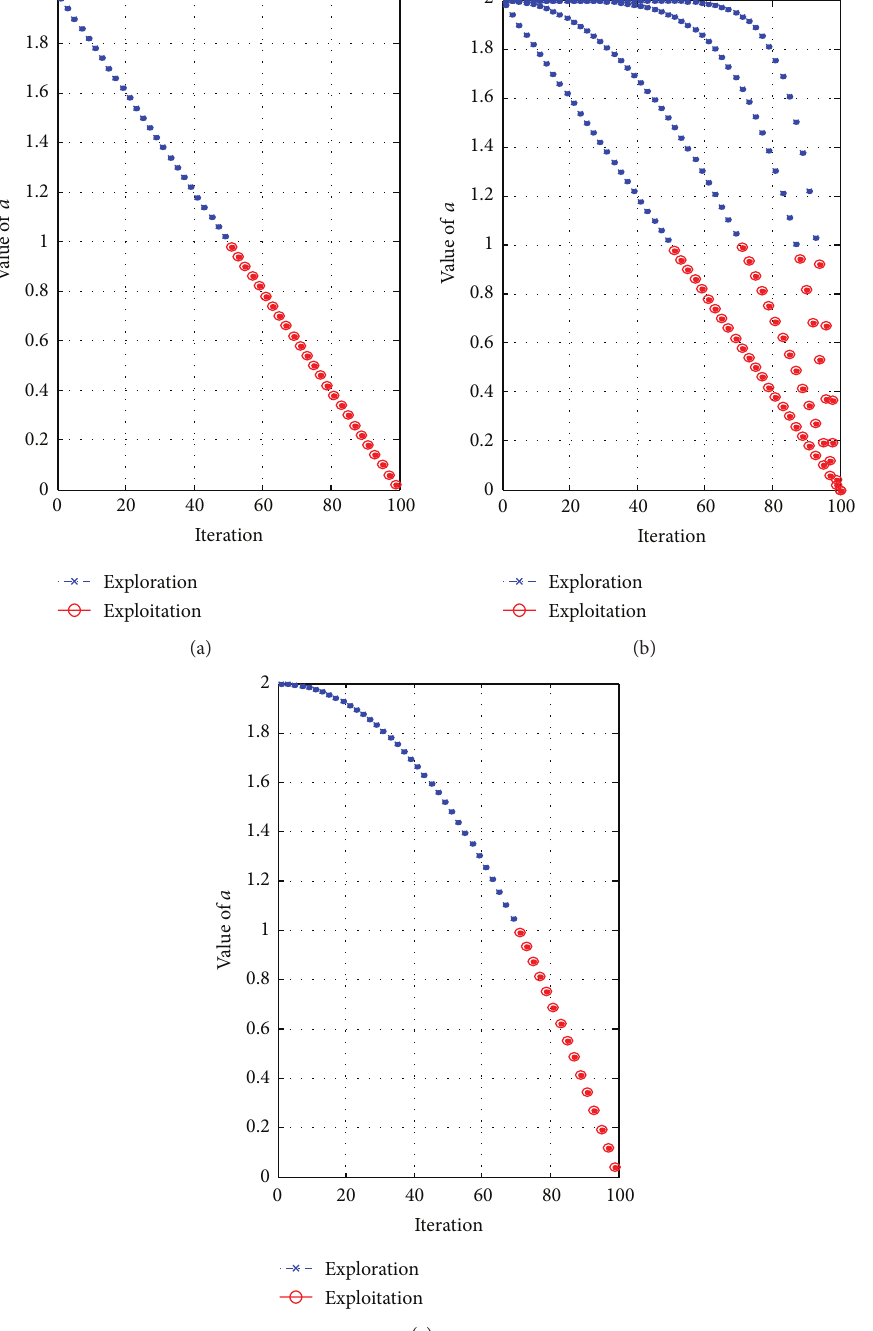
Figure 1: (a) Updating the value of 𝑎 for GWO, (b) some samples of possible functions for updating 𝑎 over the course of iterations, and (c) updating the value of 𝑎 over the course of iterations for